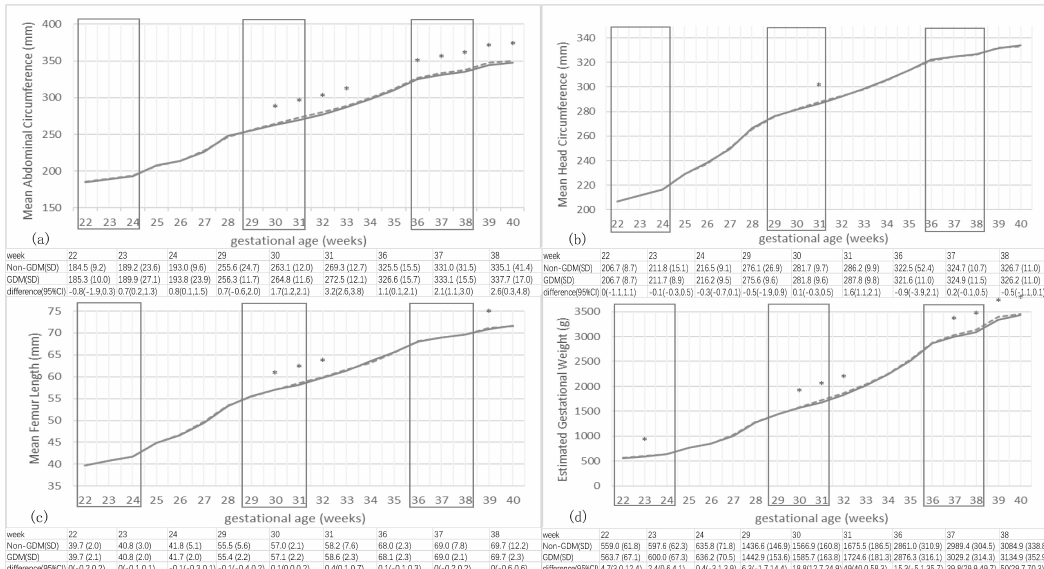
Figure 1. Comparison of mean fetal biometry in gestational diabetes mellitus (GDM) and non-GDM mothers by gestational age. Mean Head circumference ( a ), biparietal diameter ( b ), abdominal circumference ( c ) and femur length ( d ) of fetuses in pregnancies ultimately diagnosed with gestational diabetes mellitus (GDM) (dashed line) vs. pregnancies that remained normoglycemic (solid line), by gestational age. * Significant di ff erence ( p < 0.05) in size between GDM-exposed fetuses and unexposed fetuses. Three squares in each plot indicate weeks in which routine ultrasound scans were typically